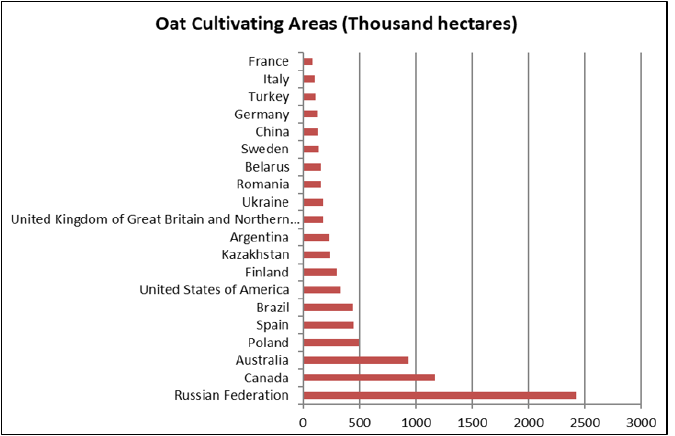
Figure 3: Oat yield in the world (2019). Source: